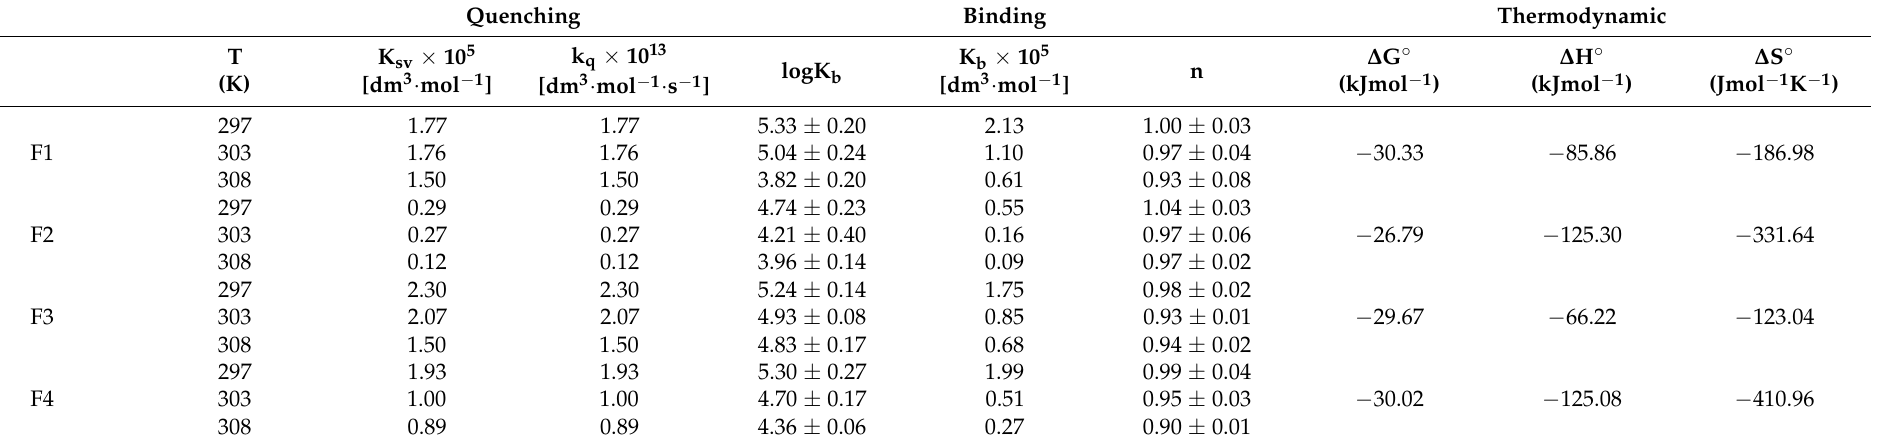
Table 1. The Stern–Volmer constant, K sv , quenching rate constant, k q , binding constant, K b , number of binding sites, n, and thermodynamic parameters for the interaction of BSA with the studied compounds at different temperatures.